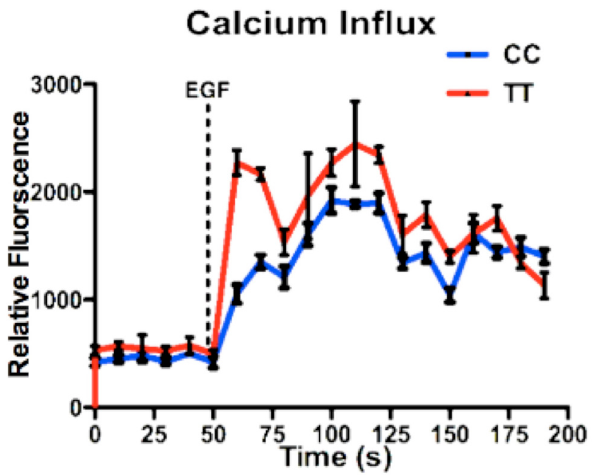
Figure 2. Gβ3s subunit leads to enhanced Ca 2+ influx kinetics. Intracellular cytosolic Ca 2+ influx was quantified using Fluo-4 NW as mentioned in materials and methods. Ca 2+ quantification assay revealed enhanced Ca 2+ influx in TT lymphoblast upon EGF stimulation, when compared to CC lymphoblast cells. Data presented in all panels are the mean with standard error (bars) of n = 3 independent experiments performed in octuplets. Statistical significance is shown as *P<0.05, **P<0.01,